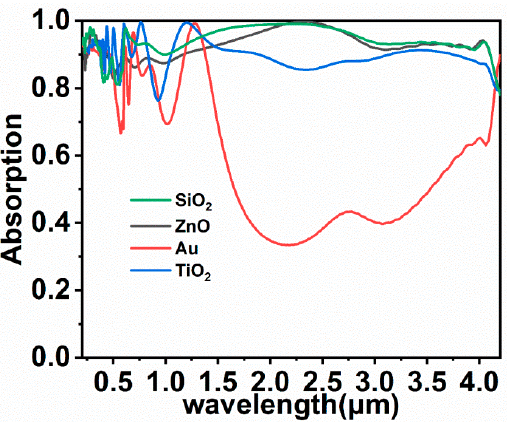
Figure 9. Absorption spectra of solar energy absorbers by employing different sphere materials. Normally, the direction of the incident light is not fixed in nature [56–58]. The ab-